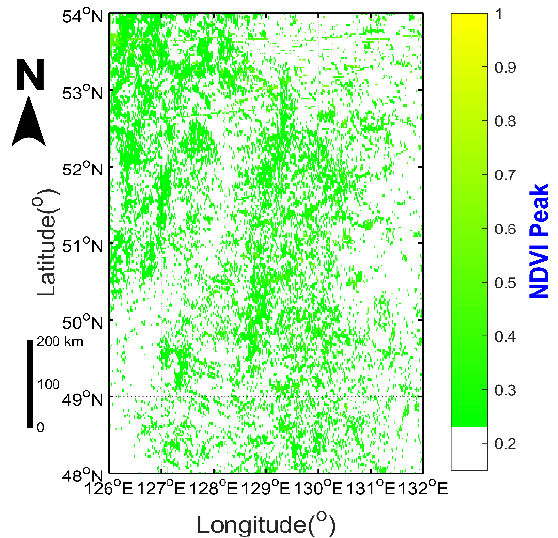
Figure 3. The peak value of normalized difference vegetation index (NDVI) in April 2016.